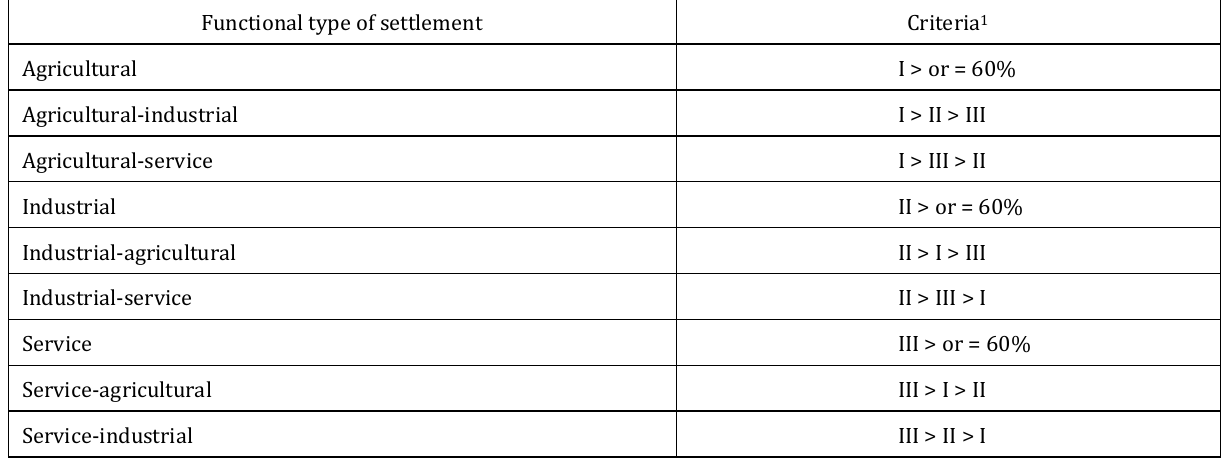
Table 2. Criteria for functional classification of settlements (Krunić et al., 2009) Functional type of settlement Criteria